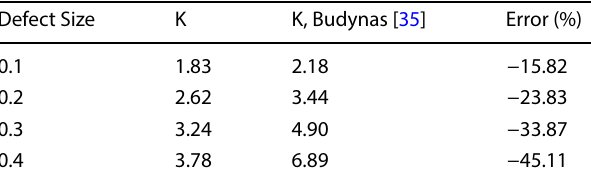
Table 8 2× LR stress intensity factors and errors for pressure vessel configuration 3